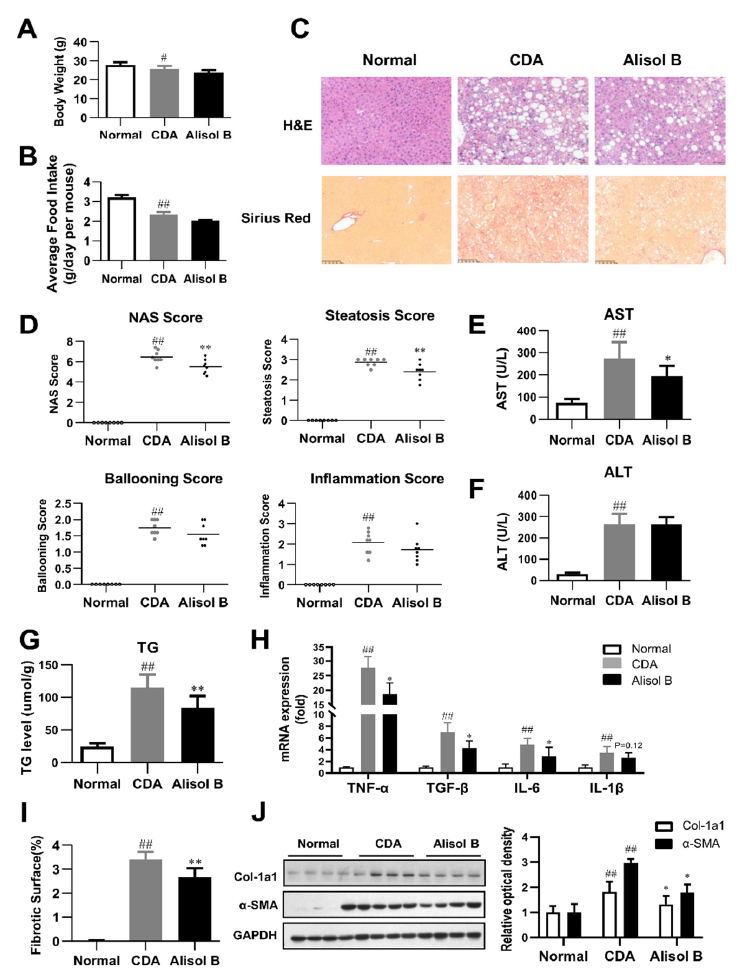
Figure 2. Alisol B ameliorated NASH in a CDA diet-induced murine model. The therapeutic effects